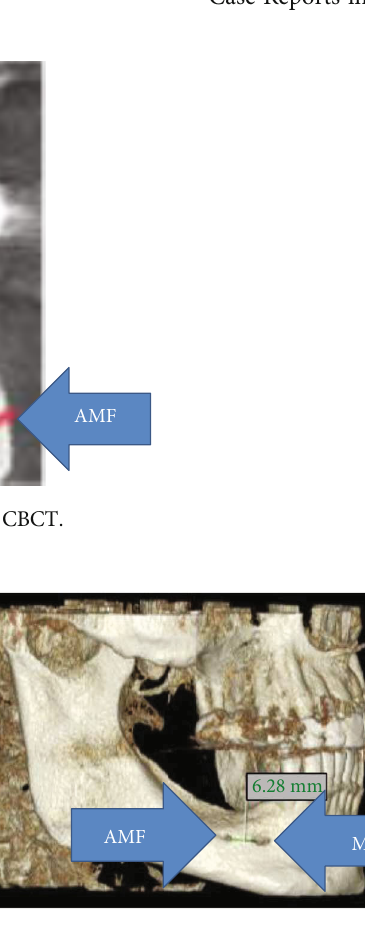
Figure 3: Right AMF at reconstructed